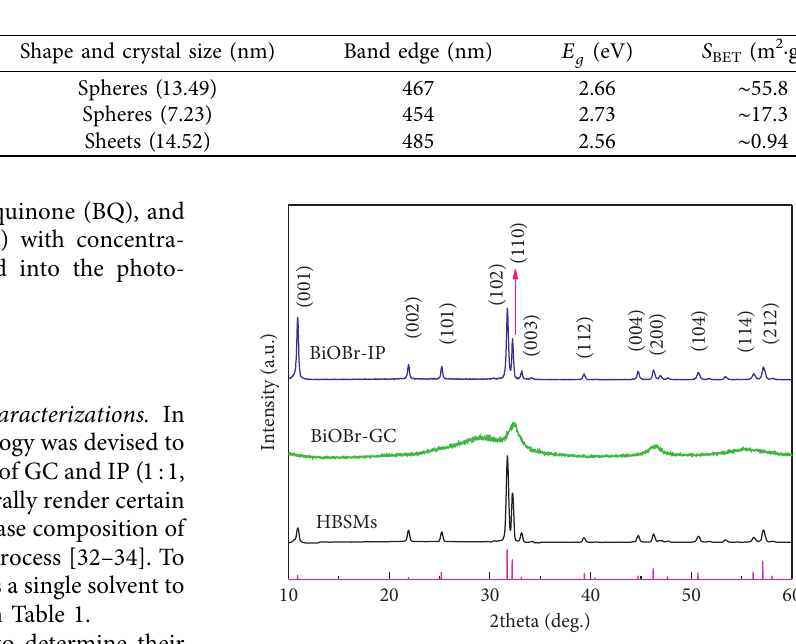
Figure 2: XRD patterns of the resultant HBSMs, BiOBr-GC, and BiOBr-IP samples. The magenta vertical lines for the standard spectrum of the BiOBr (JCPDS card no.